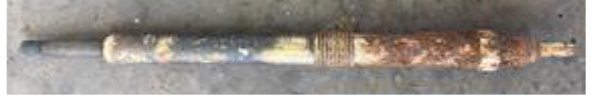
Fig. 2. The glow plug failure due to the damage to the power connection part caused by corrosion for the glow plug used in the 2009 Opel Movano 2.5 CDTI engine. Source: own elaboration